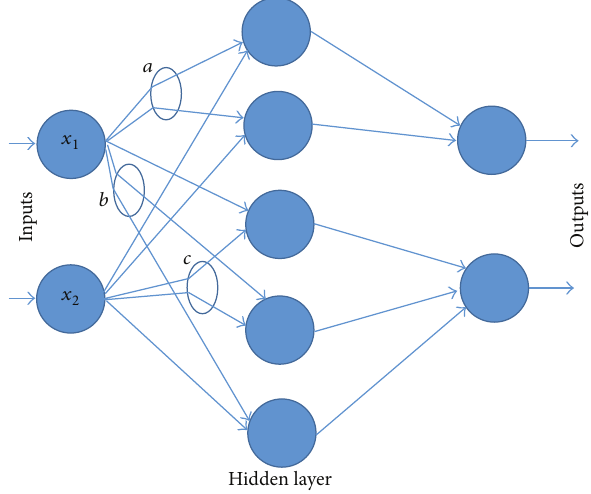
Figure 1: Architecture of the NEFCLASS-J system: 𝑥 1 and 𝑥 2 are inputs provided and {𝑎,𝑏, 𝑐} represent the shared weights in the